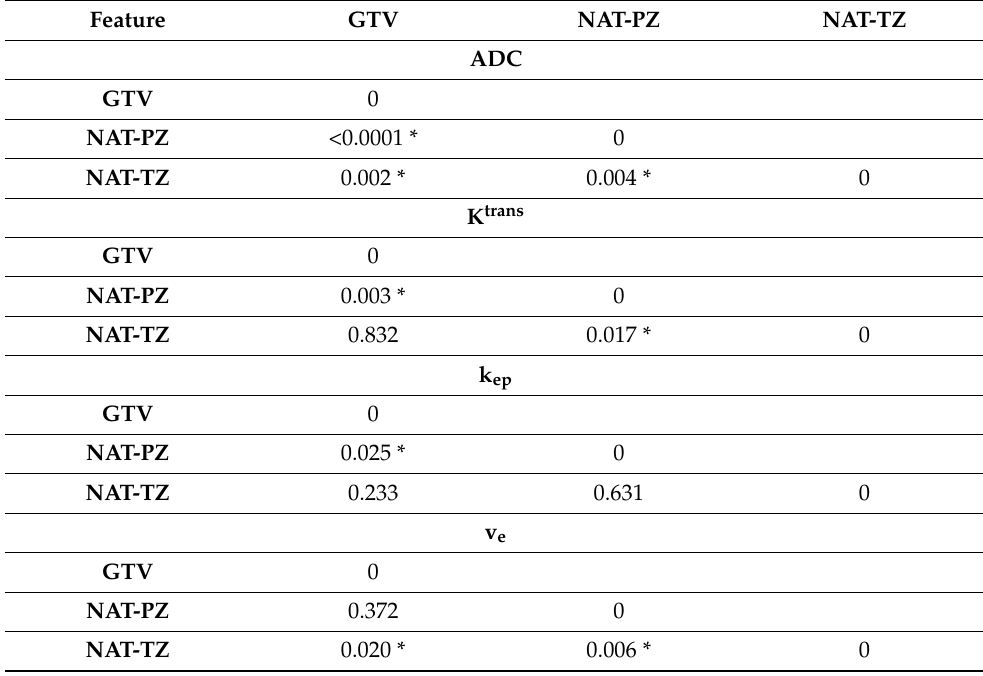
Table A2. Comparison of quantitative imaging features at baseline. The p -values from the Student’s t-test between ROIs are reported. Statistically significant values (<0.05) are marked with